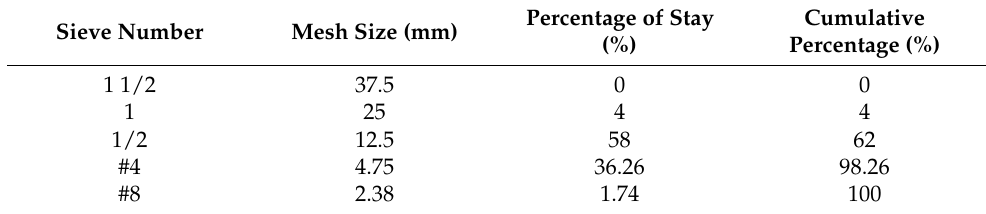
Table 10. Gradation distribution of recycled coarse